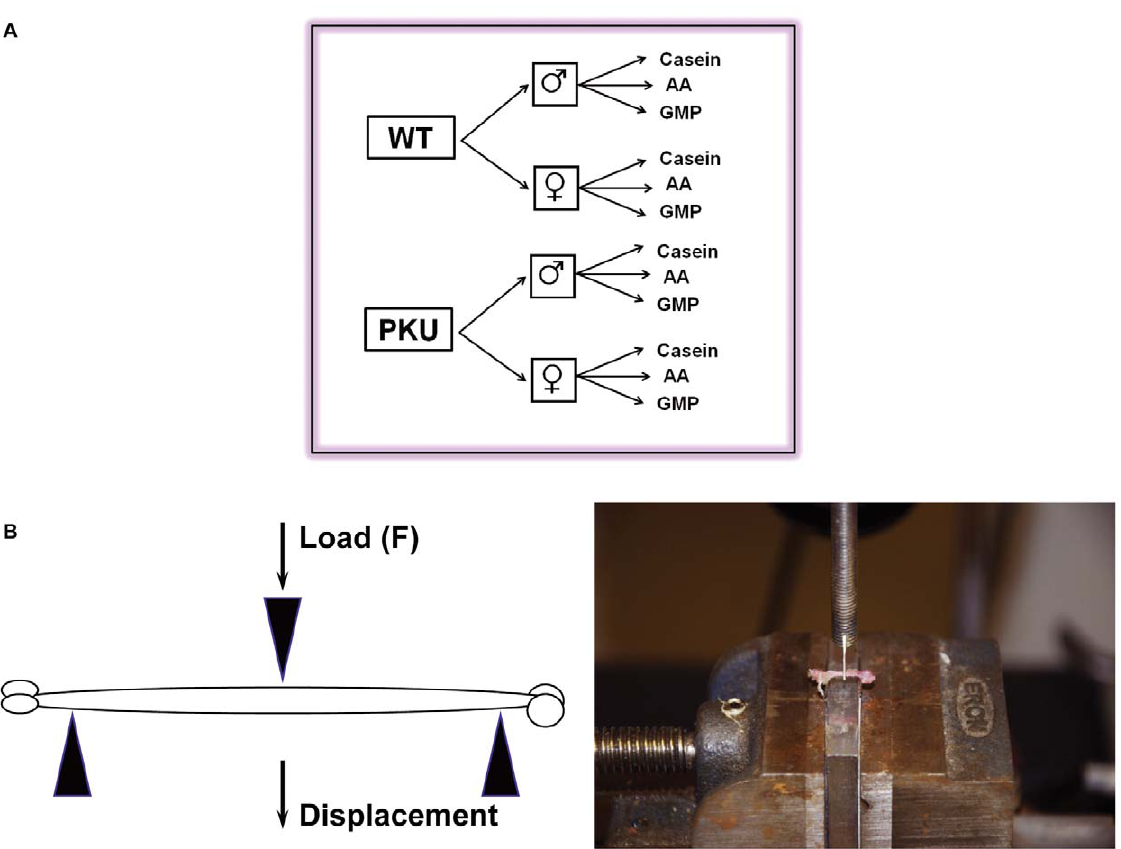
Figure 1. Experimental design and three-point bending test. The experiment utilized a 2 6 2 6 3 factorial design with a total of 12 groups (A). A cartoon of the three-point bending test of a mouse femur and a representative photograph